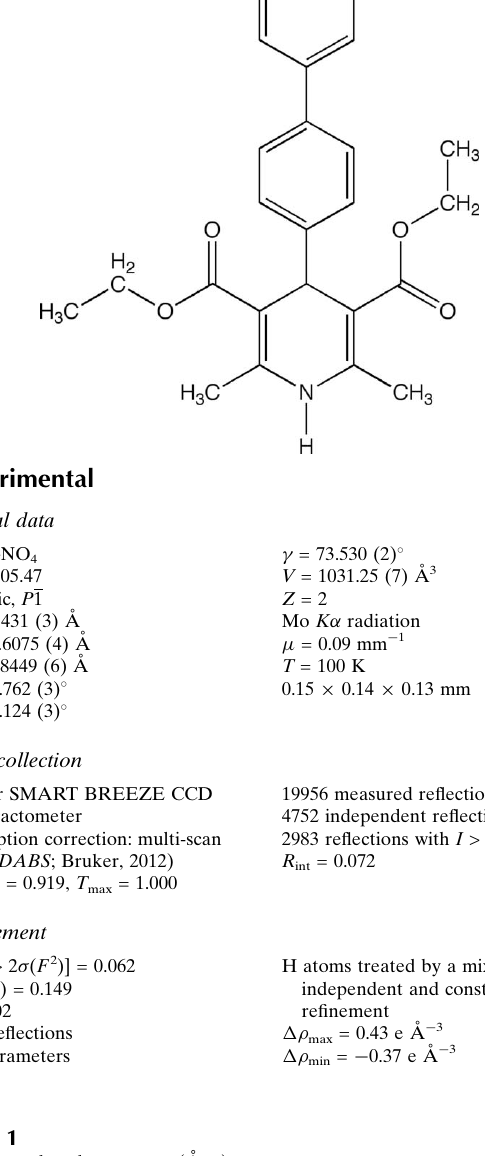
Hydrogen-bond geometry (A˚ , (cid:2)